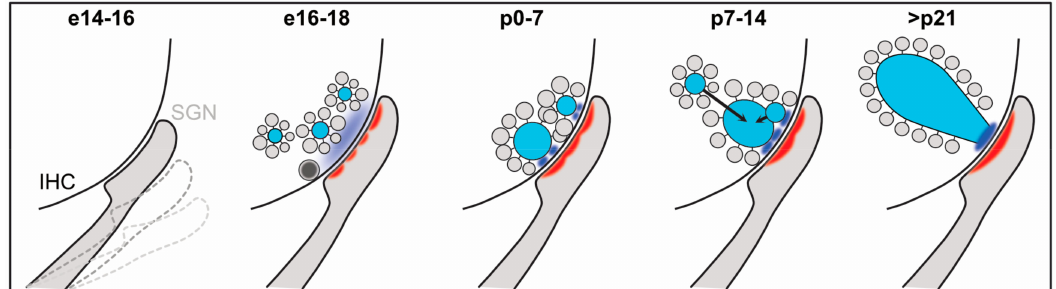
Figure 3. Synaptogenesis in murine cochlear IHCs. The formation of the synaptic connection between inner hair cells (IHCs) and spiral ganglion neurons (SGNs) starts in the late embryonic stages. A ff erent contact formation precedes the arrival of pre- and postsynaptic proteins. In the late prenatal stages, ribbon precursors (cyan) are formed in the IHC cytoplasm and already tether synaptic vesicles (SVs). The precursors translocate to the developing active zone (AZ) within the basolateral compartment of the IHC. Dense core vesicles (black and gray), may play a role in AZ-directed transport of proteins not localizing to the precursors. In early postnatal stages ribbon precursors attach at the presynaptic membrane, where they fuse alongside their individual presynaptic densities (dark blue). Subsequently, ribbons grow and the size of the attached SVs decreases, while their number increases until hearing onset. Simultaneously, the postsynaptic densities convert from multi-cluster organization to one ellipsoid density per bouton. Developmental refinement of both pre- and postsynapse results in the innervation of predominantly one AZ per SGN and—in the majority of synapses—one single large, droplet-shaped and mature ribbon per